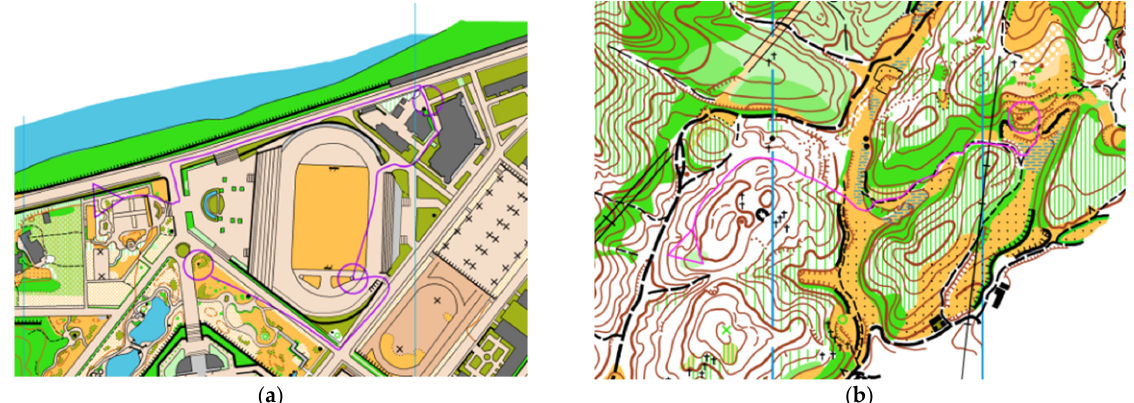
Figure 1. Specialized scene experiment materials. ( a ) Description of simple maps; this type of map contains mainly towns and parks as the field and the symbols of the types of features are mostly simple landforms and man-made features. ( b ) Description of complex maps; this type of map contains mainly mountain scenes in the field, and the map is mostly symbols of landforms.